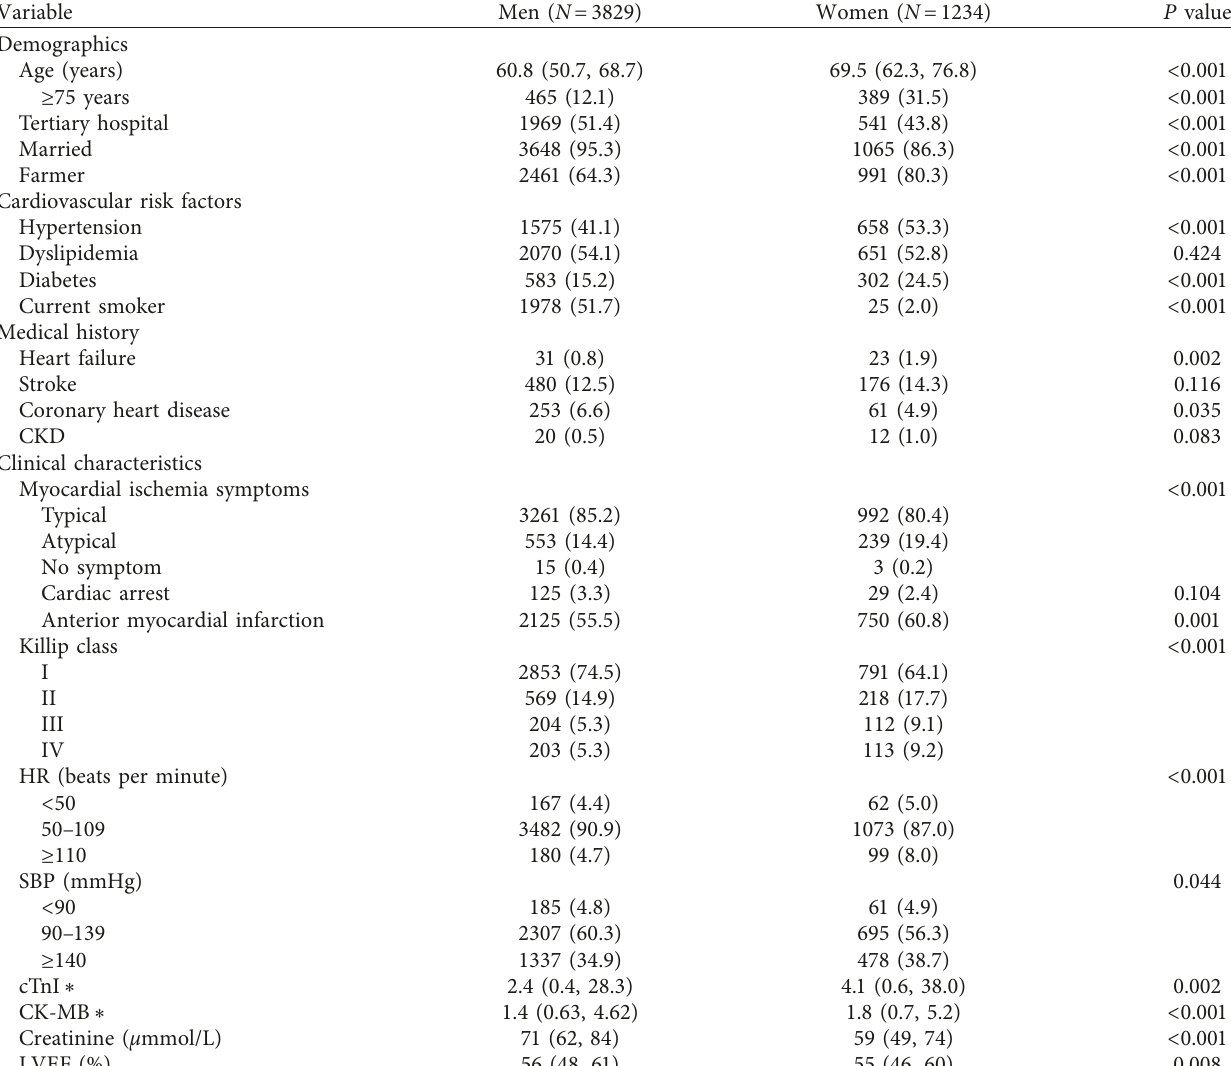
Table 1: Baseline characteristics of the study group: demographics, cardiovascular risk factors, medical history, and clinical characteristics at